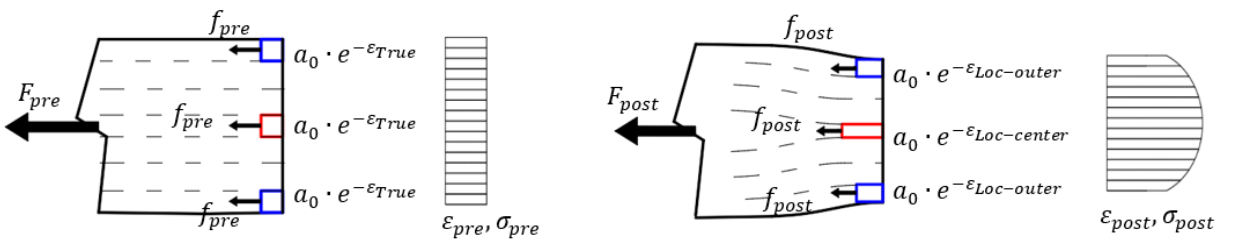
Figure 8. Discretized specimen for deriving the local-strains-based true curve. In the undeformed configuration, each sub-area a 0 is the n -th fraction of the total cross-section area A 0 : a 0 = A 0 / n